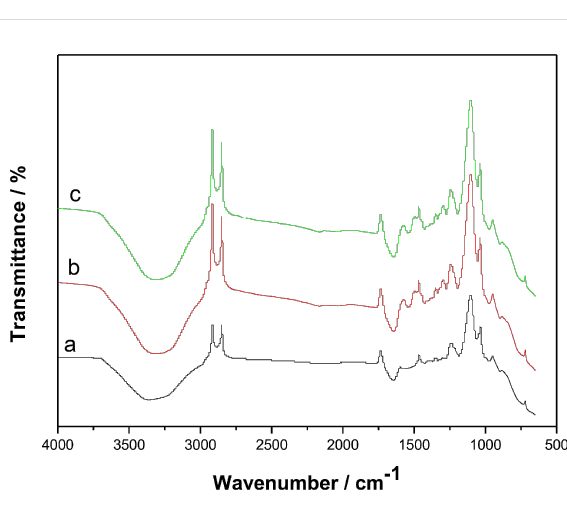
C=O bond of carboxyl [38] and the O–H bond [39].